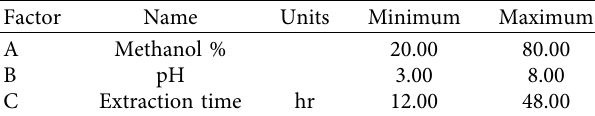
Table 1: Factors and its levels used for the present study.